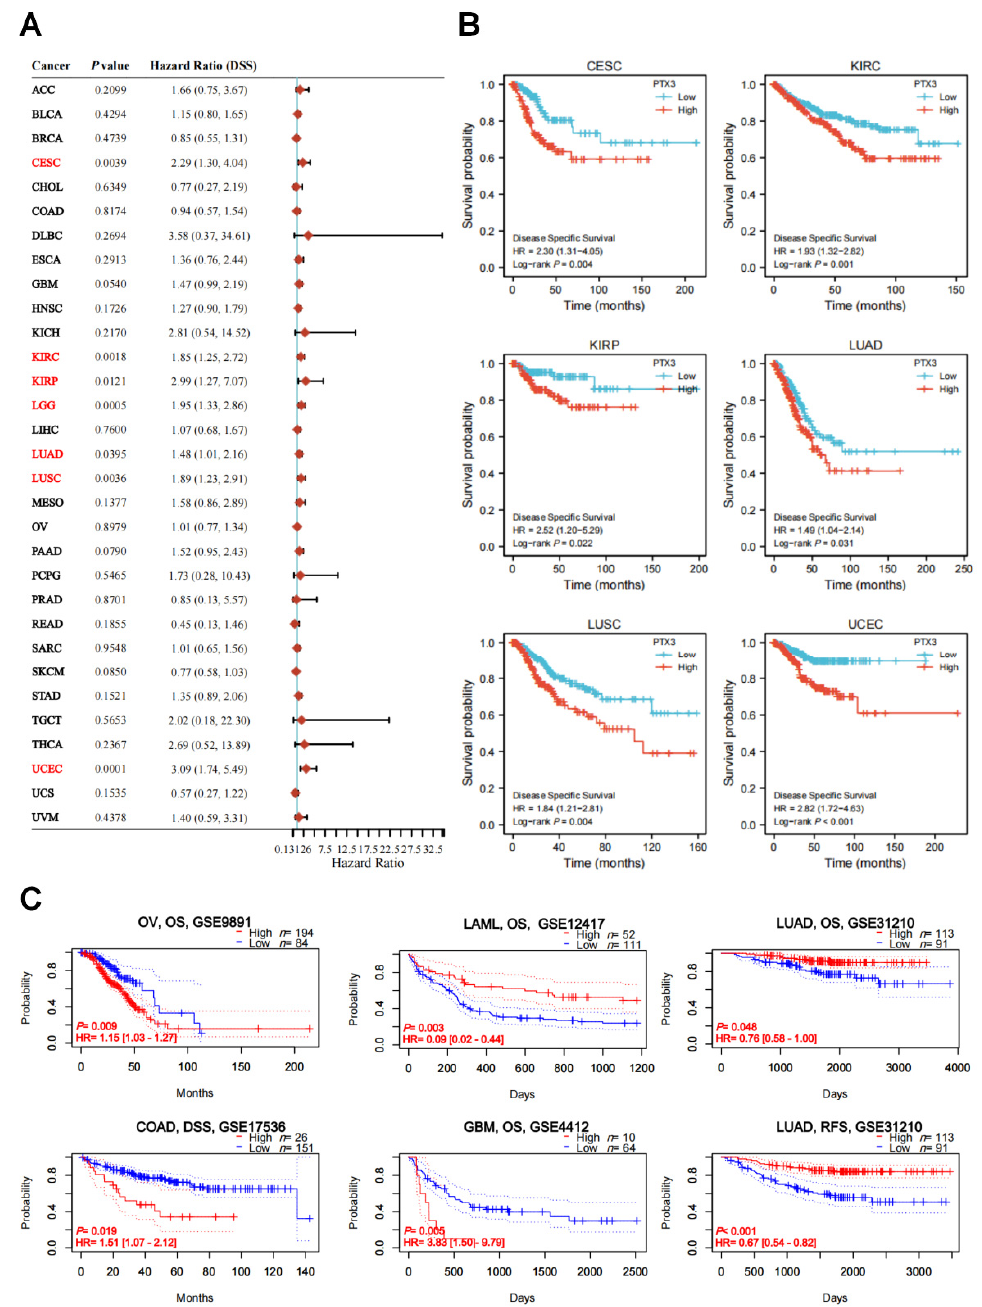
Figure 4. PTX3 expression with DSS: ( A ) Forest plot showed univariate Cox regression analysis of PTX3 in pan-cancers (red color indicated statistical significance); ( B ) KM curves of the association between PTX3 expression and DSS in cancers; ( C ) PTX3 prognostic value in the GEO database based on the PrognoScan database.